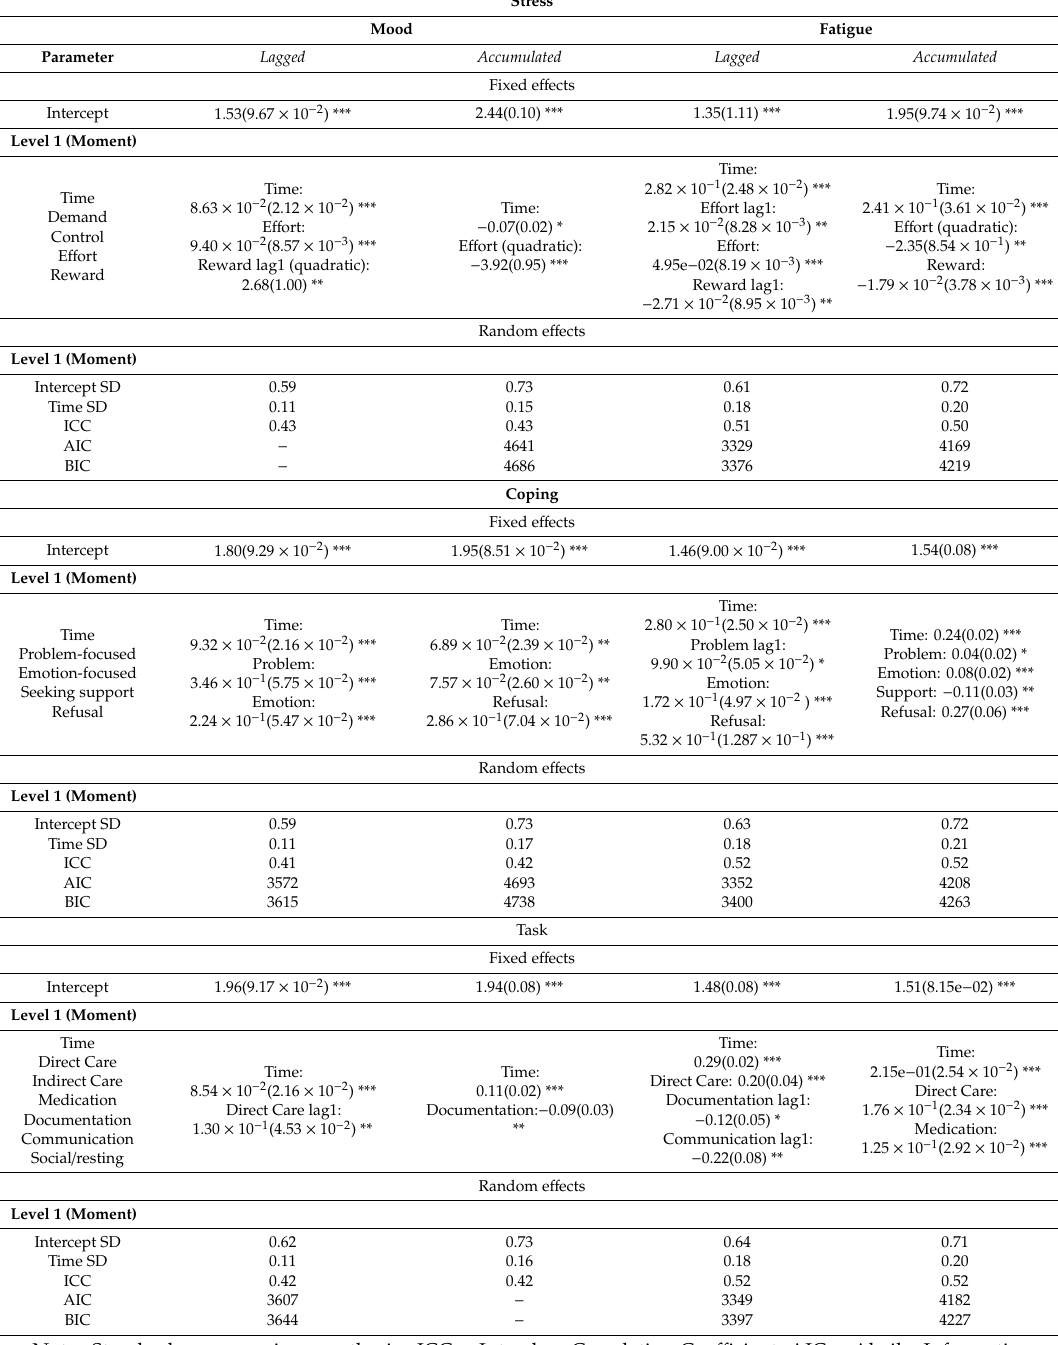
Table 1. Fixed-e ff ects estimates, variance estimates: standard error and the fit indices for the fitted models of the predictors of lagged and accumulated e ff ects on mood and